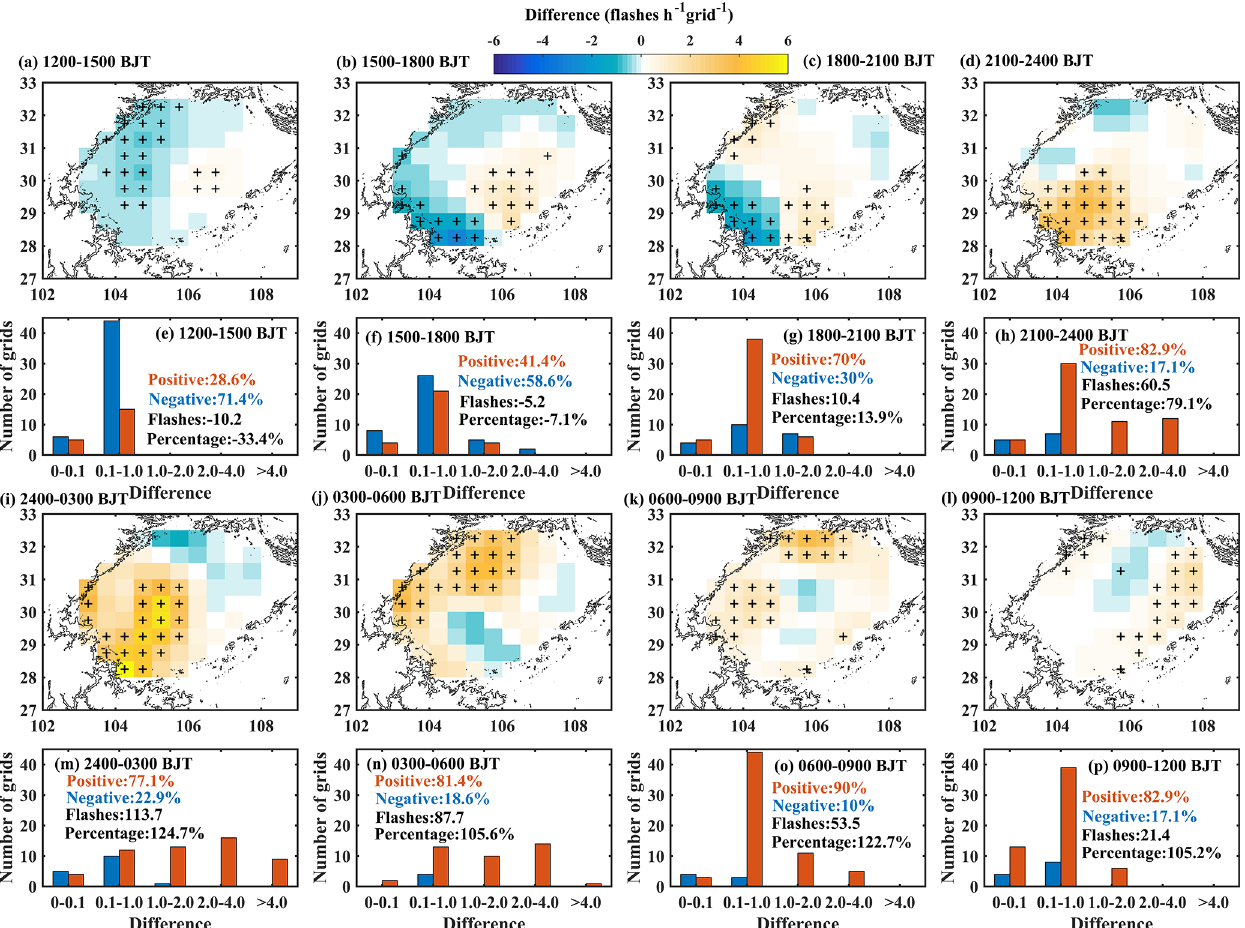
Figure 6. (a–d, i–l) Diurnal changes of total CG lightning flash differences (unit: flashesh − 1 ) between polluted and clean subset (polluted– clean) during the study period with an interval of 3h (BJT). The 1500m altitude line is shown with black lines to highlight the location of the basin. The spatial resolution is 0 . 5 ◦ × 0 . 5 ◦ . Warm (cold) colours in the figure mean more (less) lightning flashes in the polluted subset. Plus signs denote those grids with relatively large difference in lightning flashes (the absolute value of difference in lightning flashes ranks in the top third). (e–h, m–p) Histograms of the differences (red: positive, blue: negative) between lightning flashes in the polluted and clean subsets. The percentages of grids with the positive (negative) difference in the total grids, the total change of lightning flashes, and its percentage are also